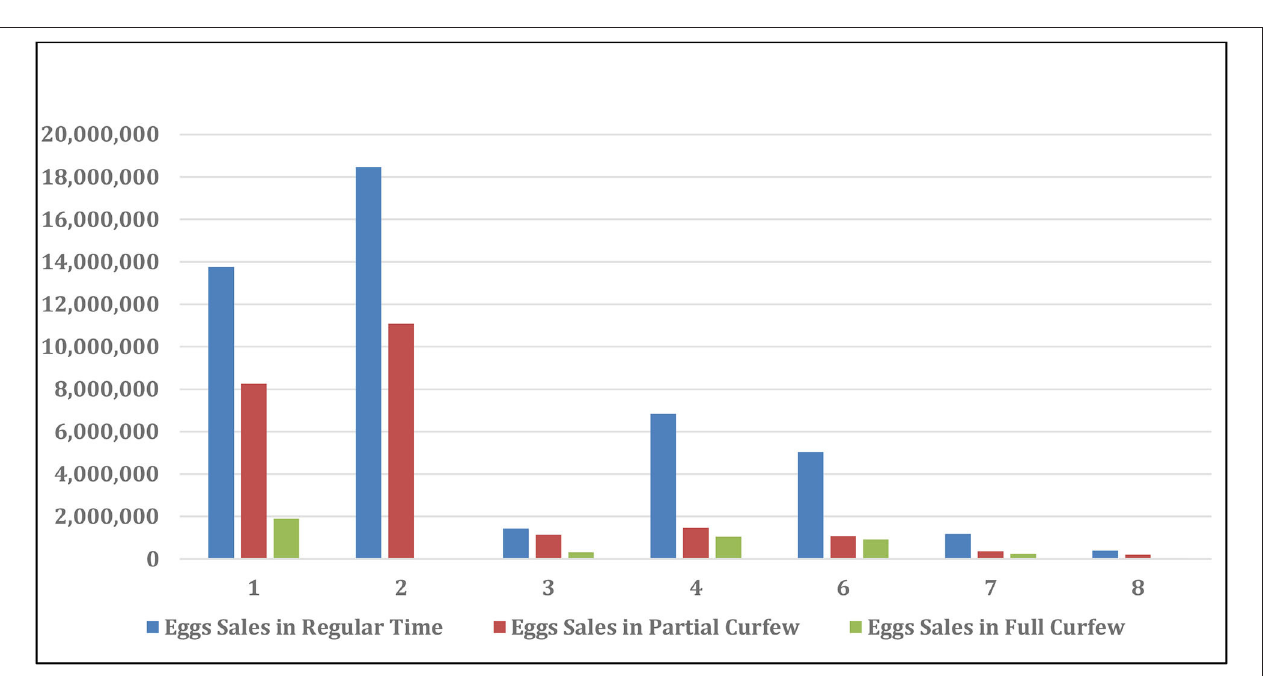
FIGURE 4 | Egg sales in USD before and after SARS-Con-V2